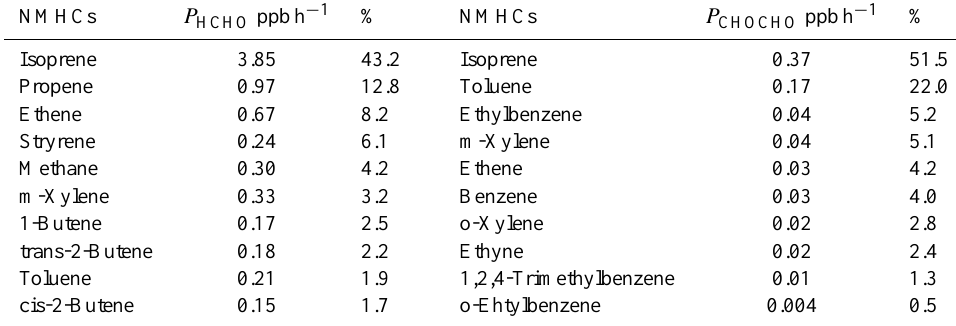
Table 2. Top-10 precursor NMHCs of HCHO and CHOCHO for the 6 cloud-free days during the PRIDE-PRD2006 campaign. NMHCs